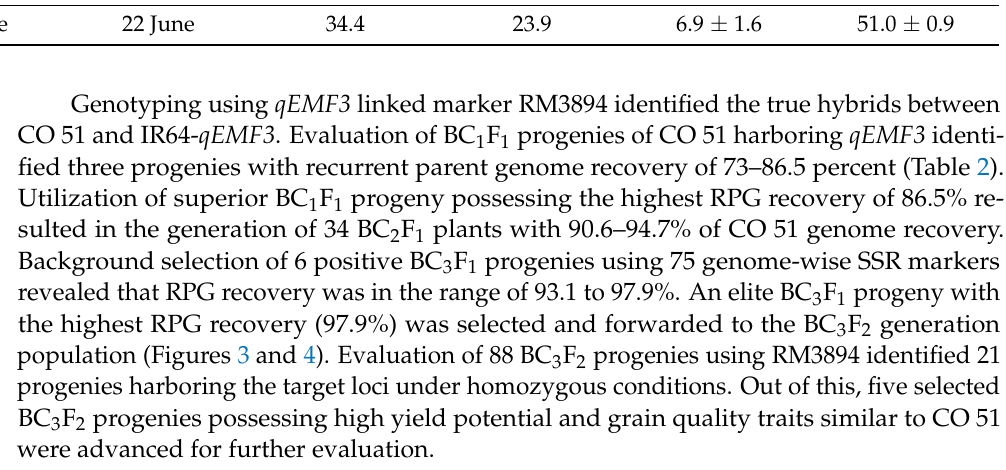
Grain Sterility % Yield/Plant (g)